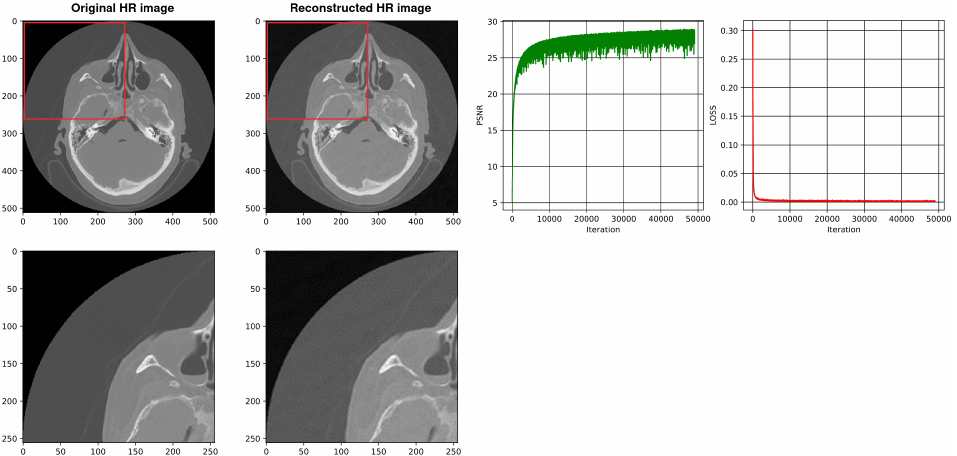
Figure 11. Shows the reconstruction of HR images using a three-layer SIREN without our architecture. The best PSNR is 28.80.